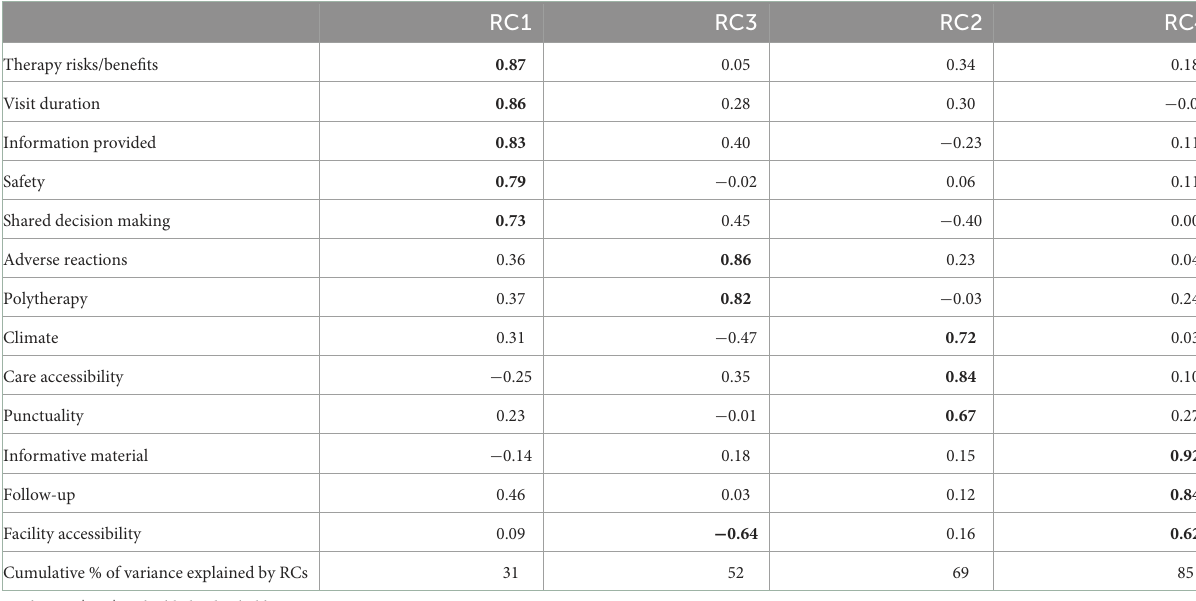
TABLE 4 Item loadings on RCs and cumulative percentage of variance accounted for by RCs.